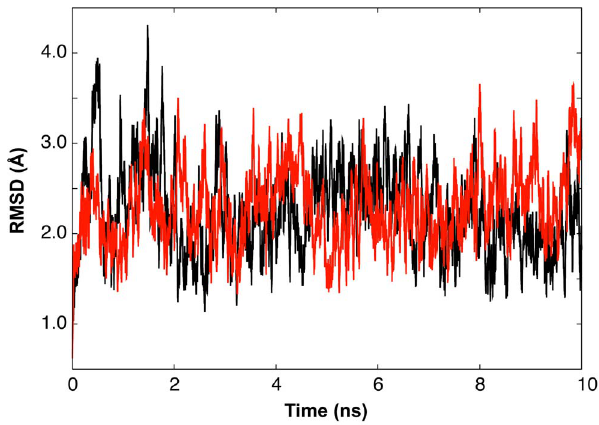
Figure 5. The trajectories of the rmsd values of the backbone heavy atoms of the double-stranded dodecamer DNA from those atoms of the initial crystal structure, along 10 ns MD simulations with the PME method (black line, r c =12 A˚ and a = 0.35 A˚ 2 1 ) and with the ZD method (red line, r c =12A˚ and a = 0.0). Both methods started from the same initial structure.